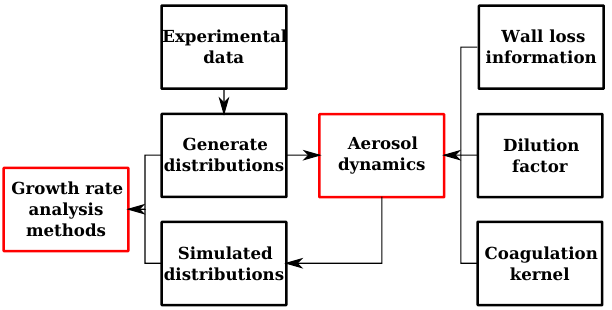
Figure A1. Flow chart describing the principle of the data